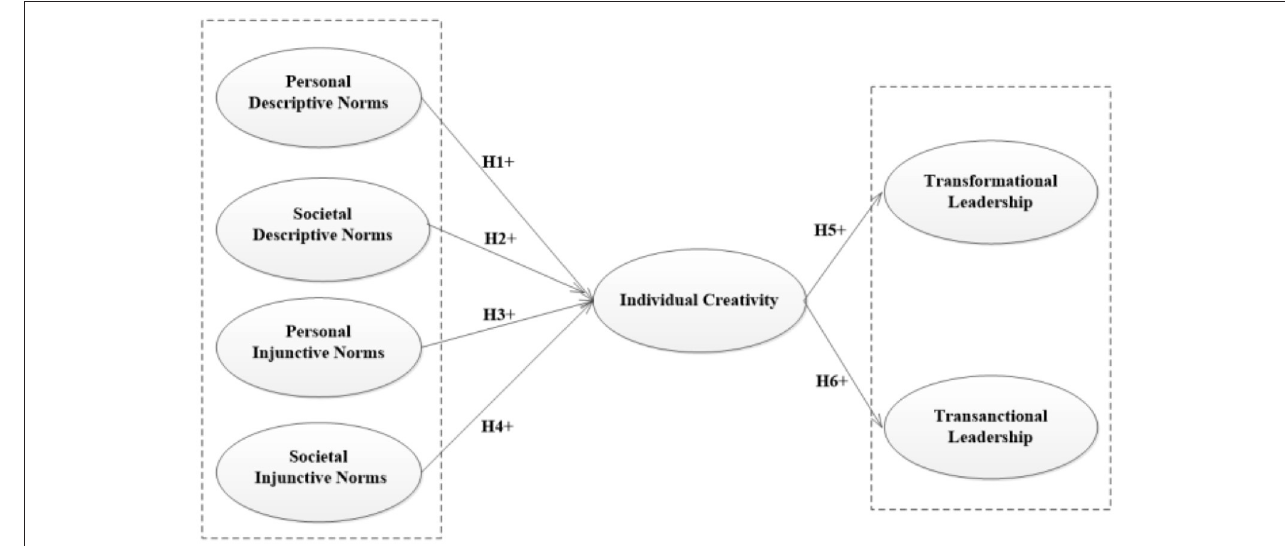
FIGURE 1 | Conceptual